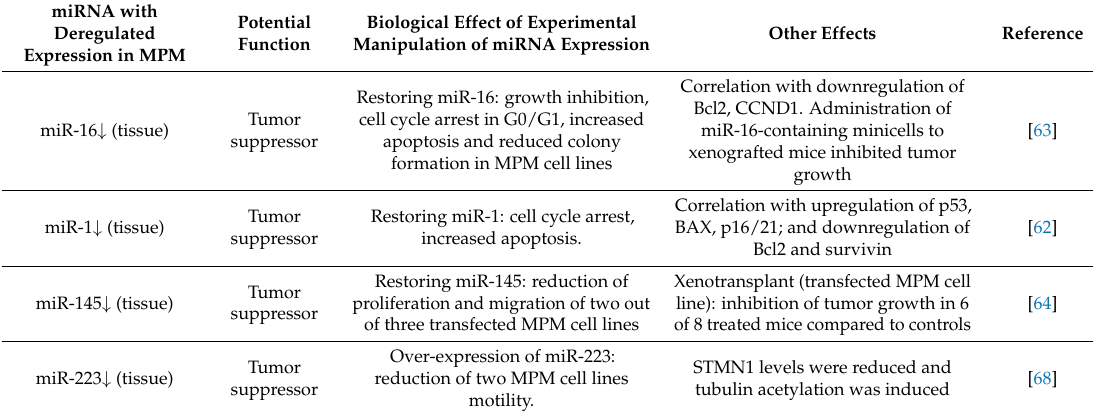
Table 3. Deregulated miRNAs associated with carcinogenesis mechanisms in